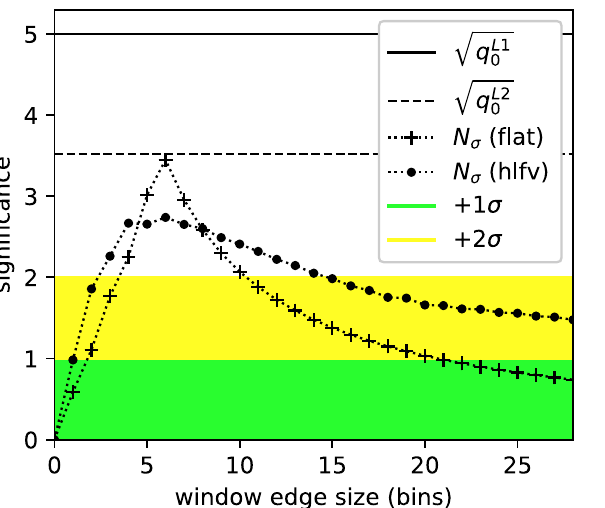
Fig. 4 ROC curves comparing results of the N σ , q L 1 the Higgs LFV example, with injected signal strength corresponding to and q L 2 0 0 5 σ of q L 1 0